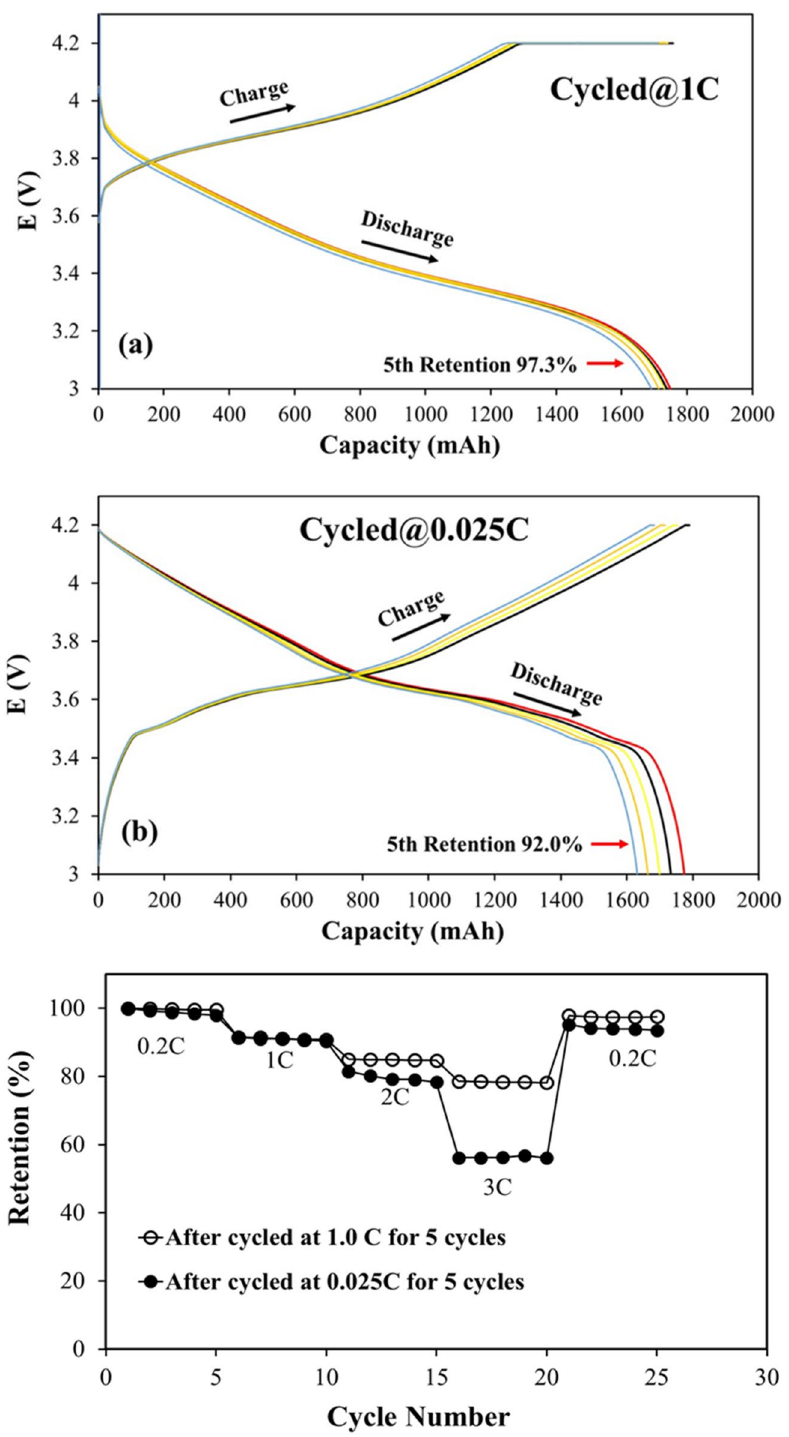
Figure 1. Galvanostatic charge/discharge at ( a ) 1 C and ( b ) 0.025 C for 5 cycles of the NMC532/MGP cells. ( c ) The retention of rate capability of the NMC532/MGP cells after initially cycled at 1 C and 0.025 C for 5 cycles,